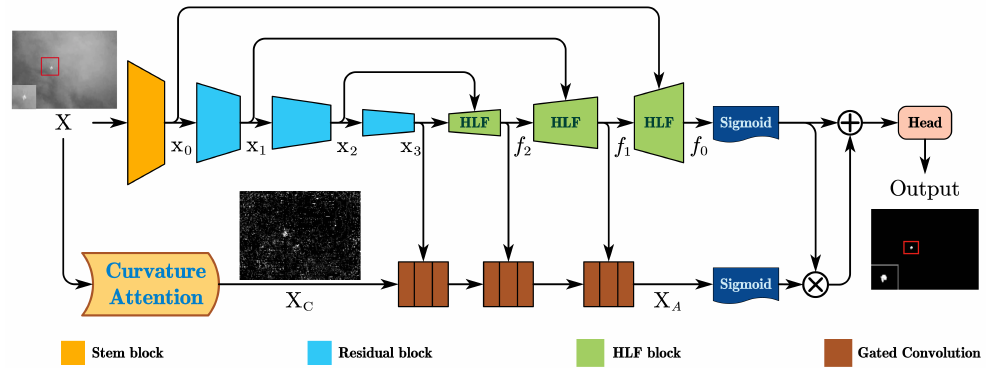
Figure 1. Overall architecture of CHFNet, with a backbone based on 4 depth UNets, HLF blocks, and curvature